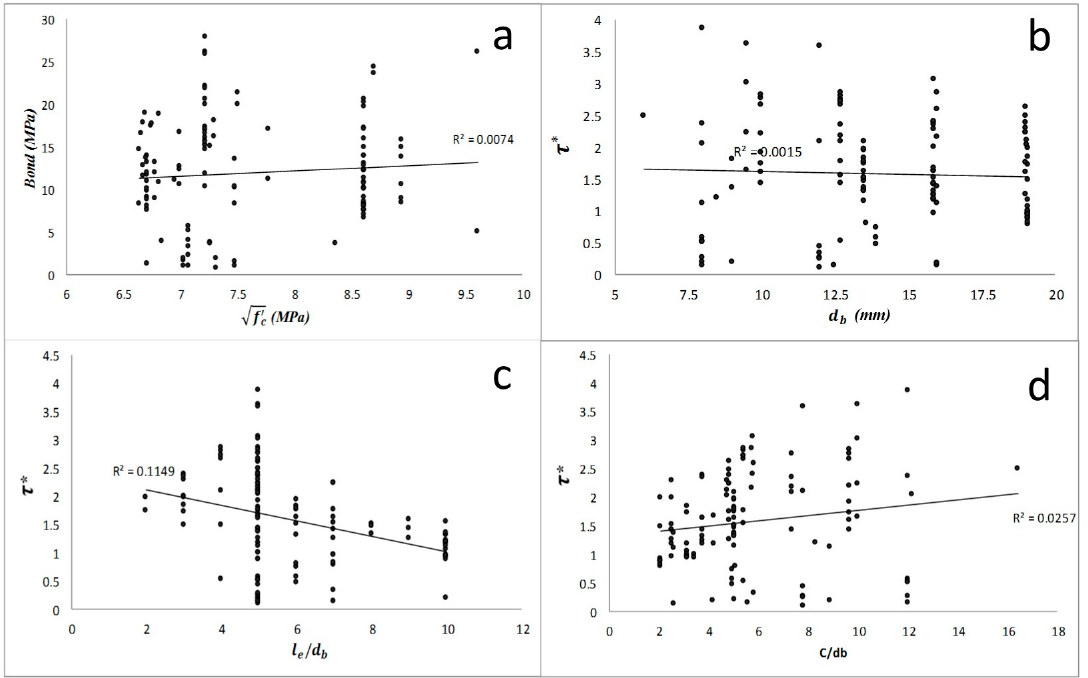
Figure 2. The effect of main factors on the bond strength of high strength concrete (study groups 3 and 4): ( a ) square root of concrete compressive strength; ( b ) bar diameter; ( c ) embedment length to bar diameter ratio; ( d ) concrete cover to bar diameter ratio. τ ∗ is the normalized bond strength.